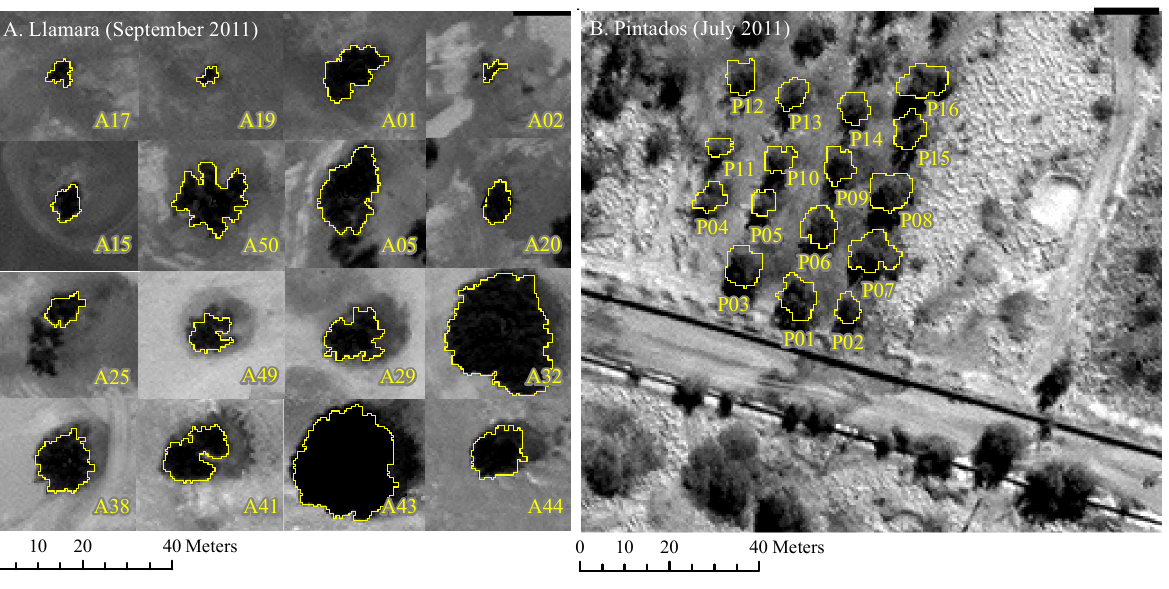
Figure 4. WorldView2 satellite images of the two sampling sites: ( A ) Llamara natural forest and ( B ) Pintados plantation. Delineated in yellow the crown of the trees identified using object-based image analysis.